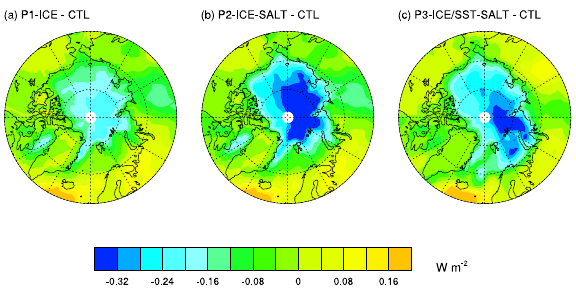
Fig. 13. Average JJA modeled TOA natural aerosol direct radia- tive forcing (Wm − 2 , relative to the CTL simulation) in response to changes in sea ice